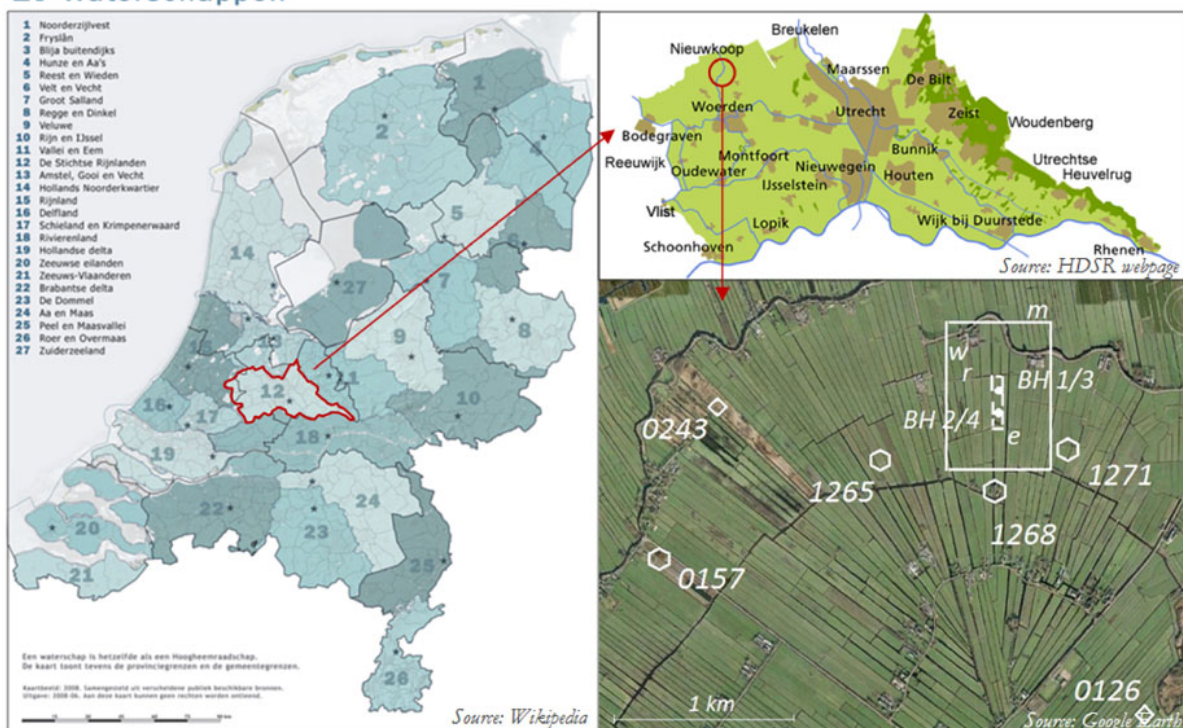
Fig. 1. Location of the research area in The Netherlands (left) within the HDRS control area (top right). (a) Research area: w=Wageningen experimental area; e=current experimental area; r=rainfall station; m=model area; polygons (e.g. 1265) are TNO boreholes with lithologi- cal description; squares (e.g. 0126) are TNO boreholes with head